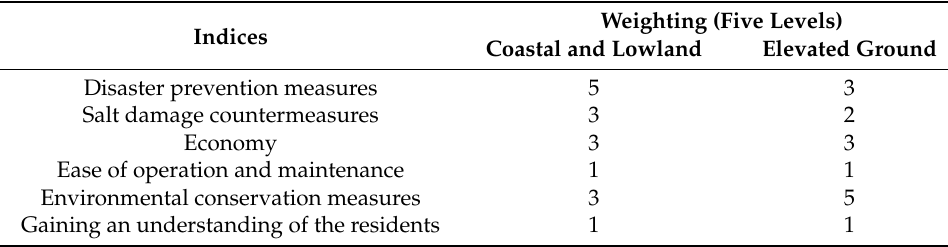
Table 2. Weights of indices for some sites of agrivoltaic power